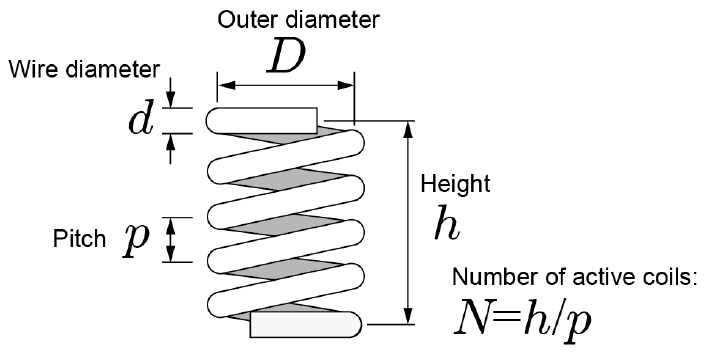
Figure 4. Structure of a coiled spring.